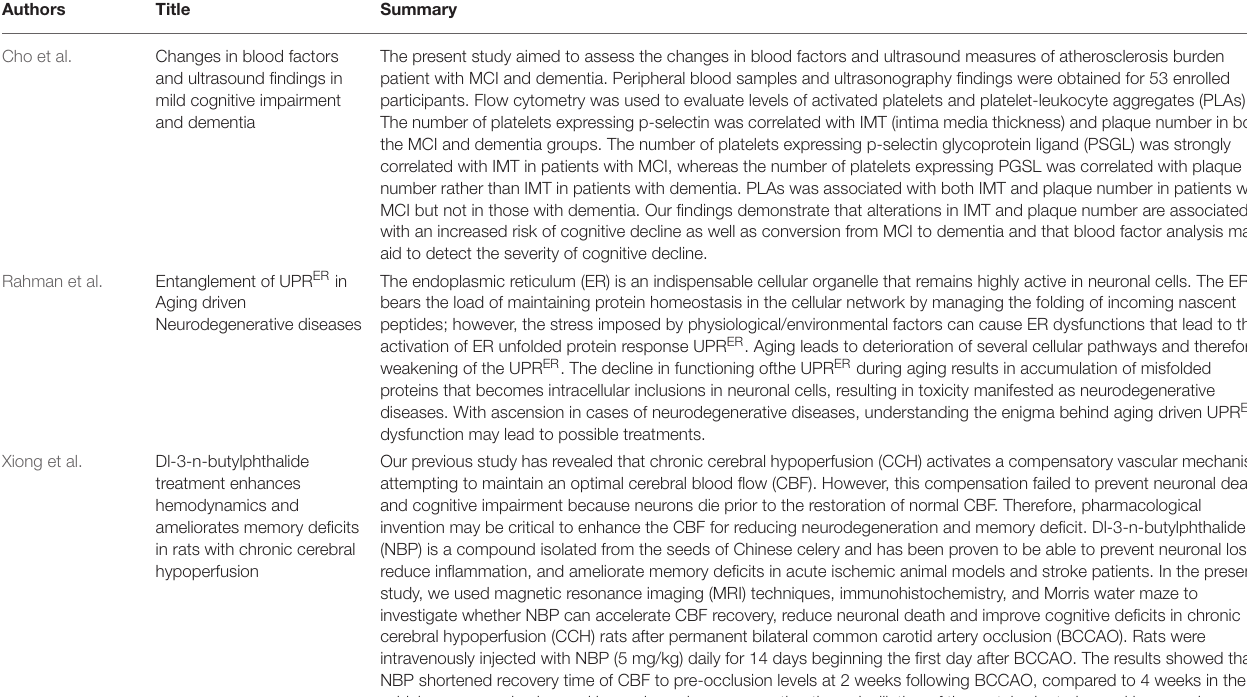
TABLE 1 | Summaries of articles in the Research Topic on Frontiers in Neuroscientific Research for Management of Dementia.